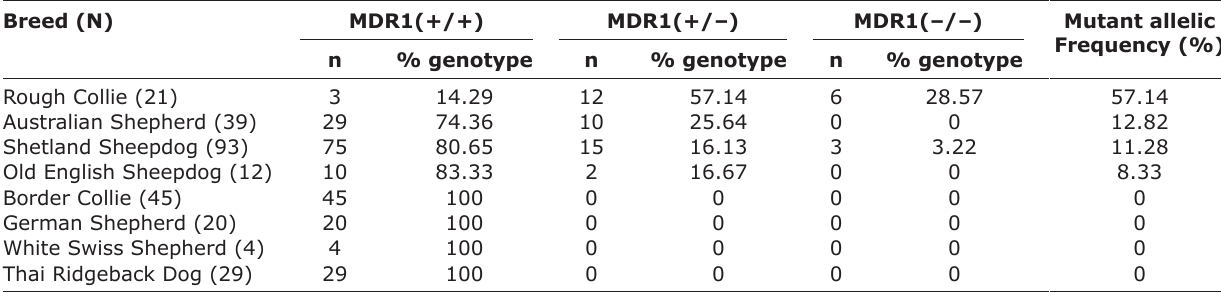
Table-2: MDR1 genotyping and mutant allelic frequency in 263 dogs of eight breeds in Thailand. Breed